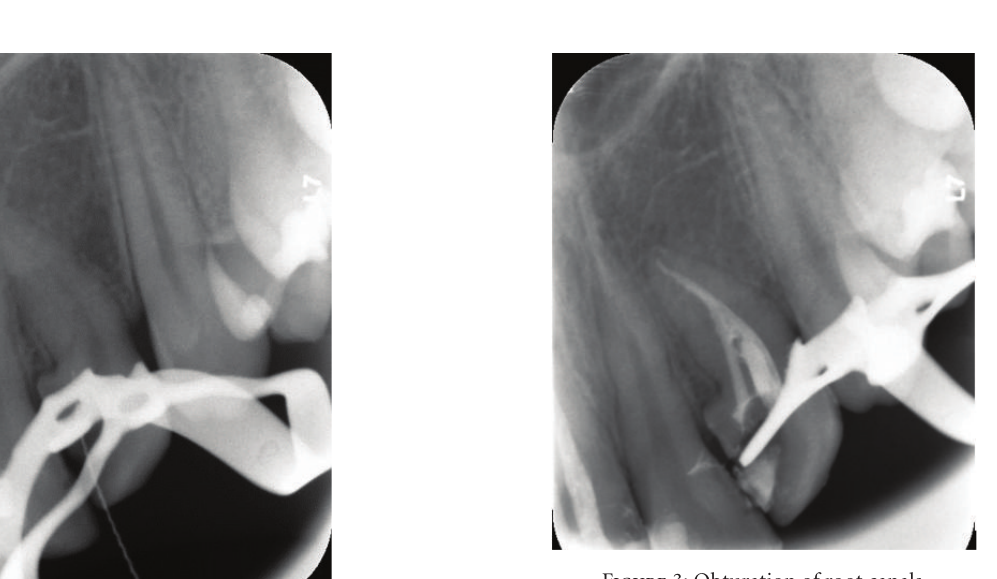
Figure 3: Obturation of root